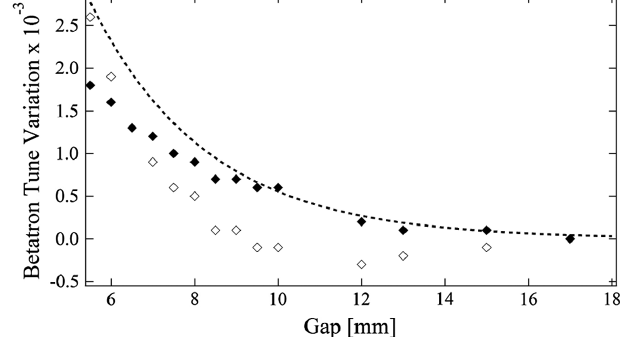
FIG. 20. Variation of the measured horizontal (white diamonds) and vertical (black diamonds) tune variation as a function of gap. The vertical tune variation is compared to the expected one from measured vertical field scaling (dashed